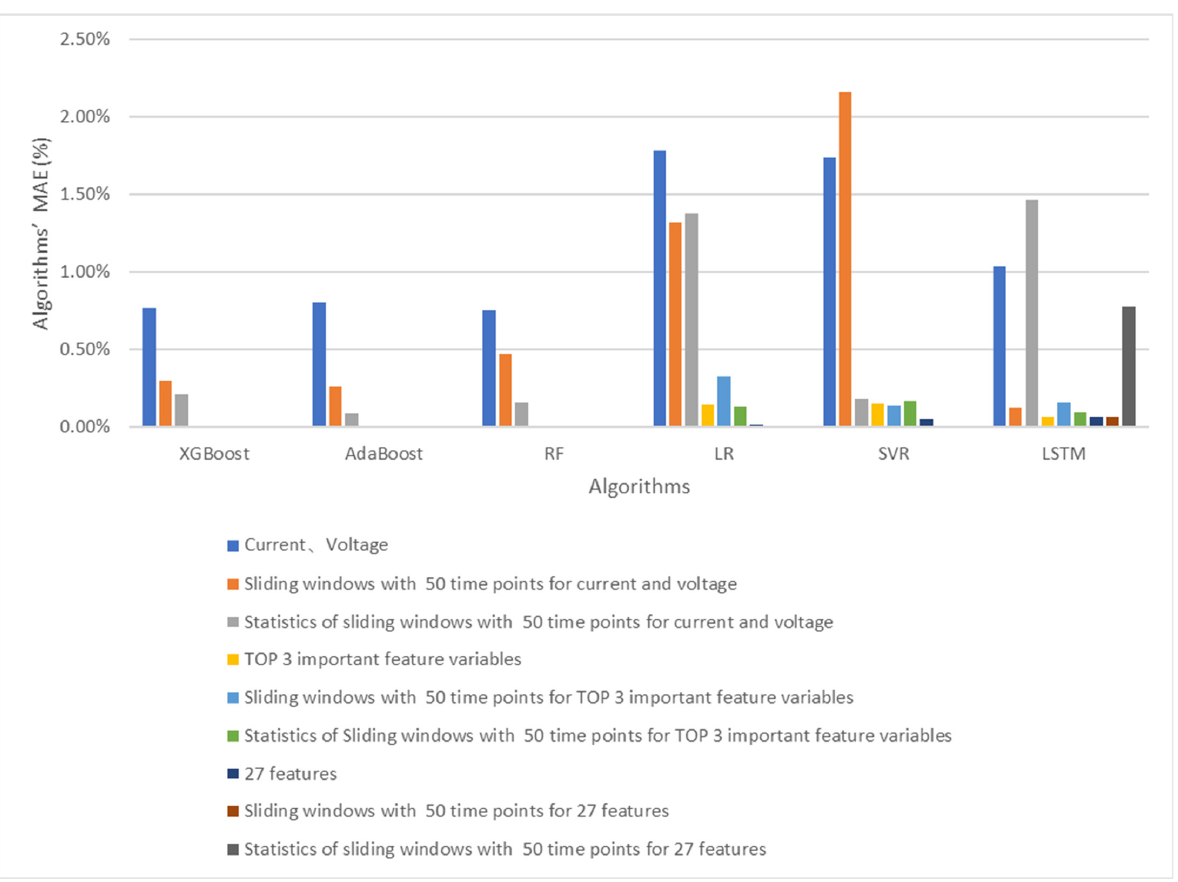
Figure 5. Comparison of algorithms’ MAE when selecting different input variables (all).